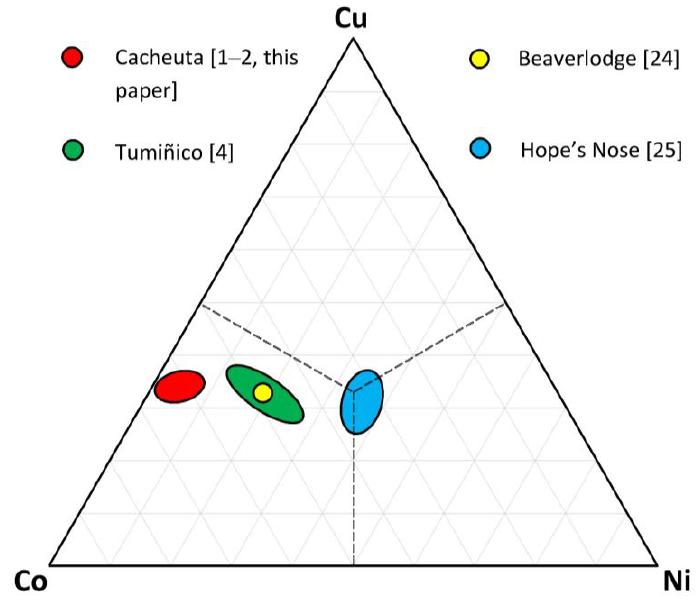
Figure 18. Co Ni Cu ternary diagram (mole %) of the system (Co,Ni,Cu) 3 Se 4 .